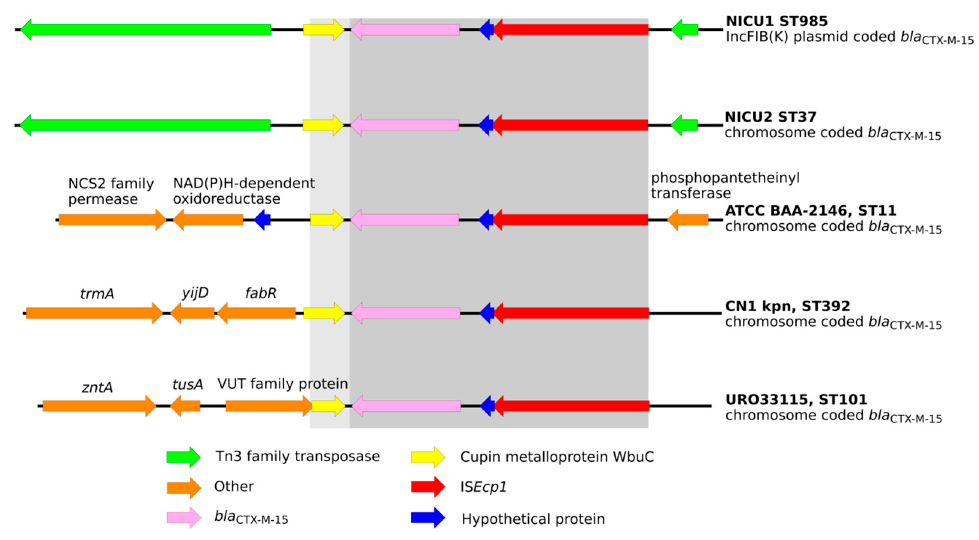
Figure 4. Schematic view of genomic fragments surrounding the IS Ecp1 transposable element containing the bla CTXM-15 gene: comparison of fragments from the NICU-1- and NICU-2-dominant clones and previously described K. pneumoniae isolates. Dark gray indicates 100% similarity between all isolates and light gray indicates high similarity.